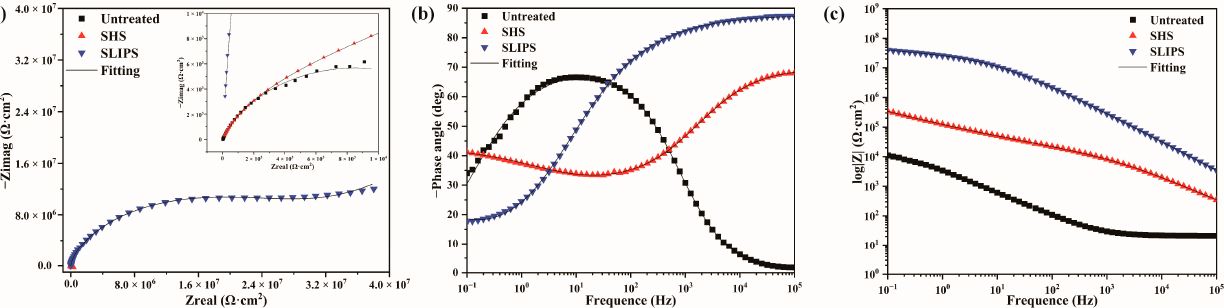
Table 1. The characteristic parameters obtained from polarization curves after immersion in simu ‐ lated seawater for 1 h.